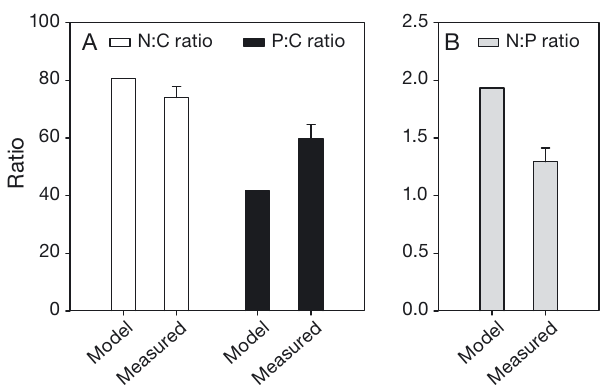
Fig. 8. Comparison between predicted and measured N:C (µg N mg –1 C), P:C (µg P mg –1 C) and N:P (mg N mg –1 P) ratios of faeces samples collected from 2 salmon